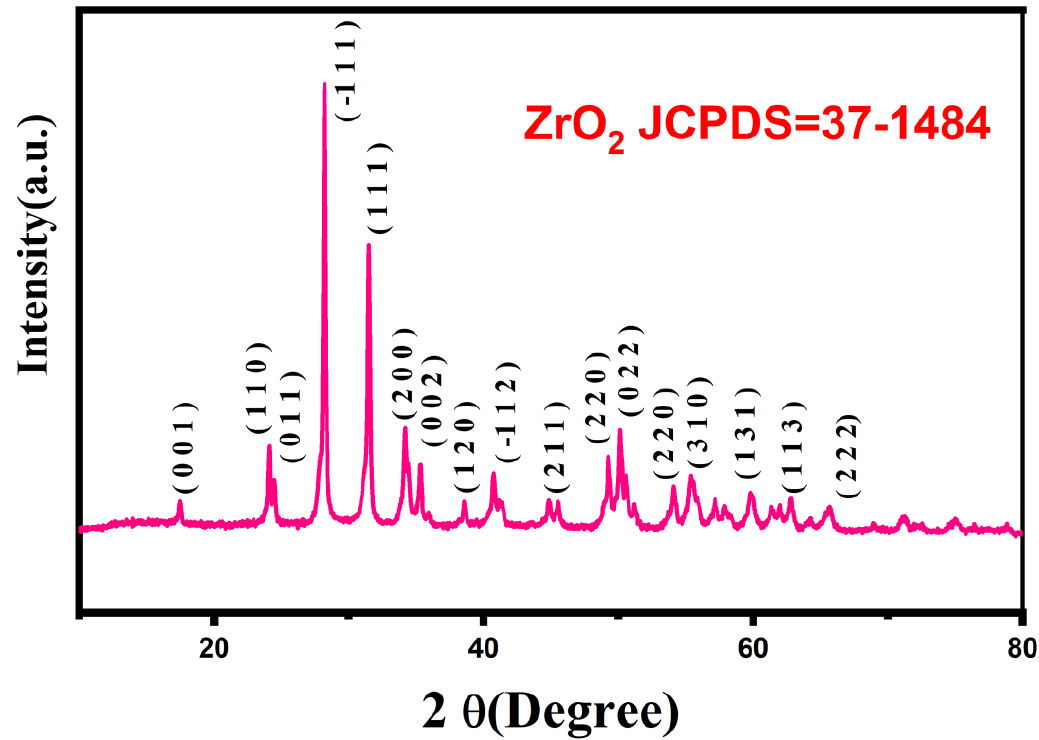
Figure 1. XRD pattern of ZrO 2 NPs.